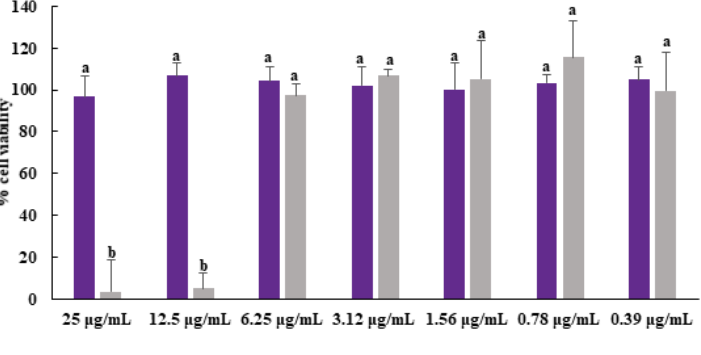
Figure 5. Effect of IBC and chlorhexidine on the viability of HaCaT cells. The results are expressed as means ± SDs. Different lowercase letters (a, b) show statistical differences between IBC and CHX according to ANOVA and Tukey’s test ( p <0.05).